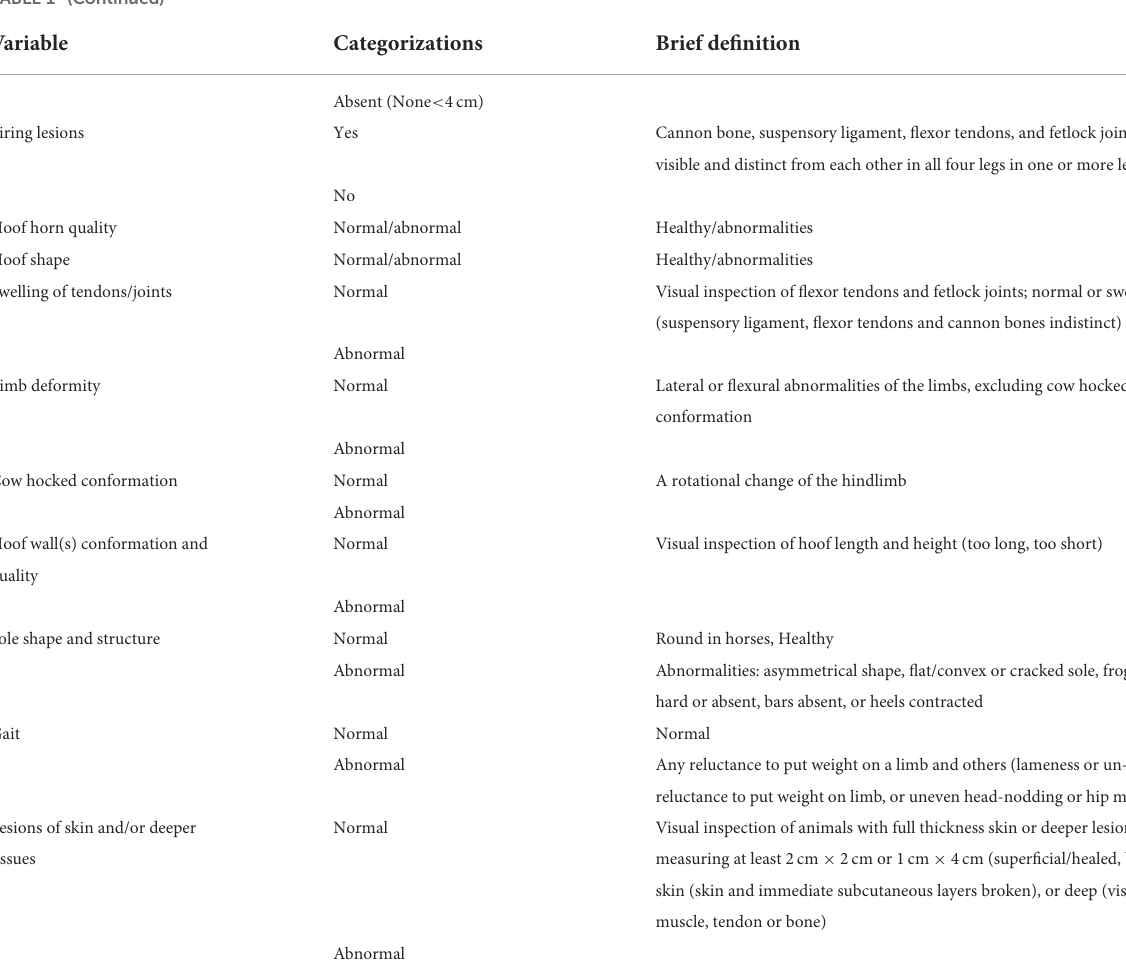
Abnormalities: asymmetrical shape, flat/convex or cracked sole, frog narrow, hard or absent, bars absent, or heels contracted Normal Any reluctance to put weight on a limb and others (lameness or un-evenness, reluctance to put weight on limb, or uneven head-nodding or hip movement) Visual inspection of animals with full thickness skin or deeper lesions measuring at least 2cm × 2cm or 1cm × 4cm (superficial/healed,